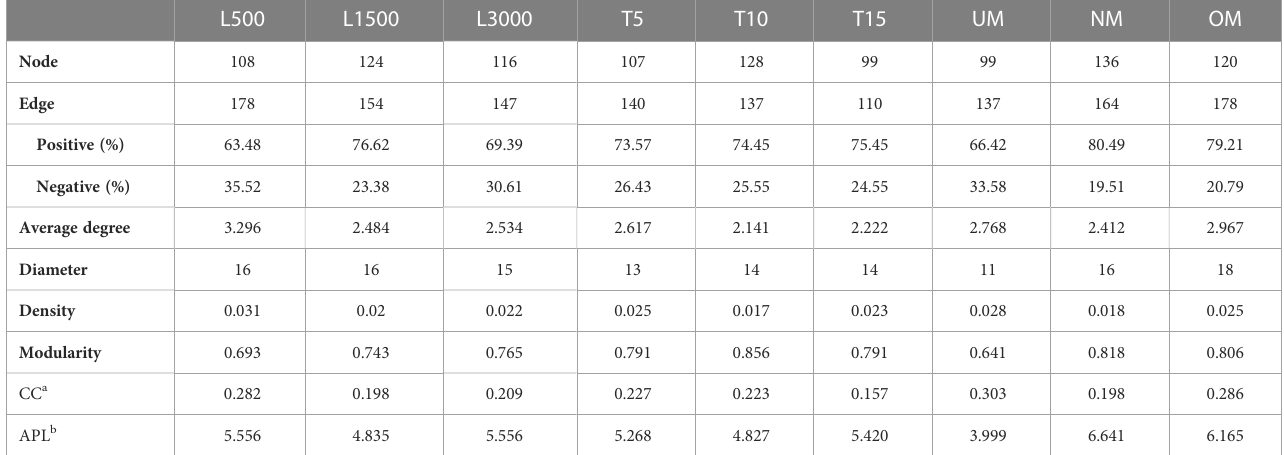
TABLE 3 Comparison of the topological parameters for all